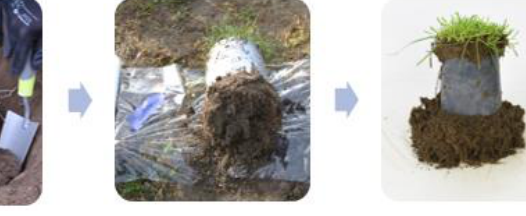
Figure 2. Preparation of the sample for laboratory tests .